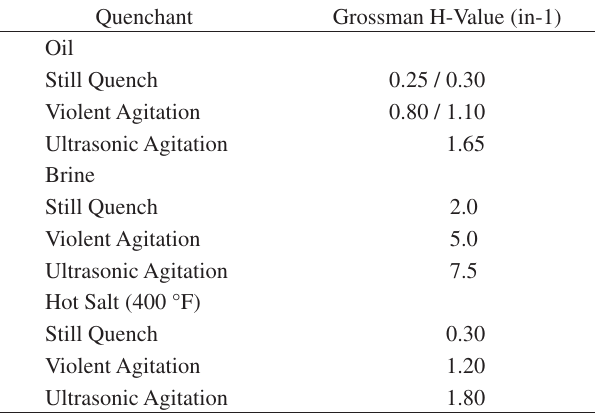
Table 1. Quench Severity Achieved with Different Modes of Agitation.